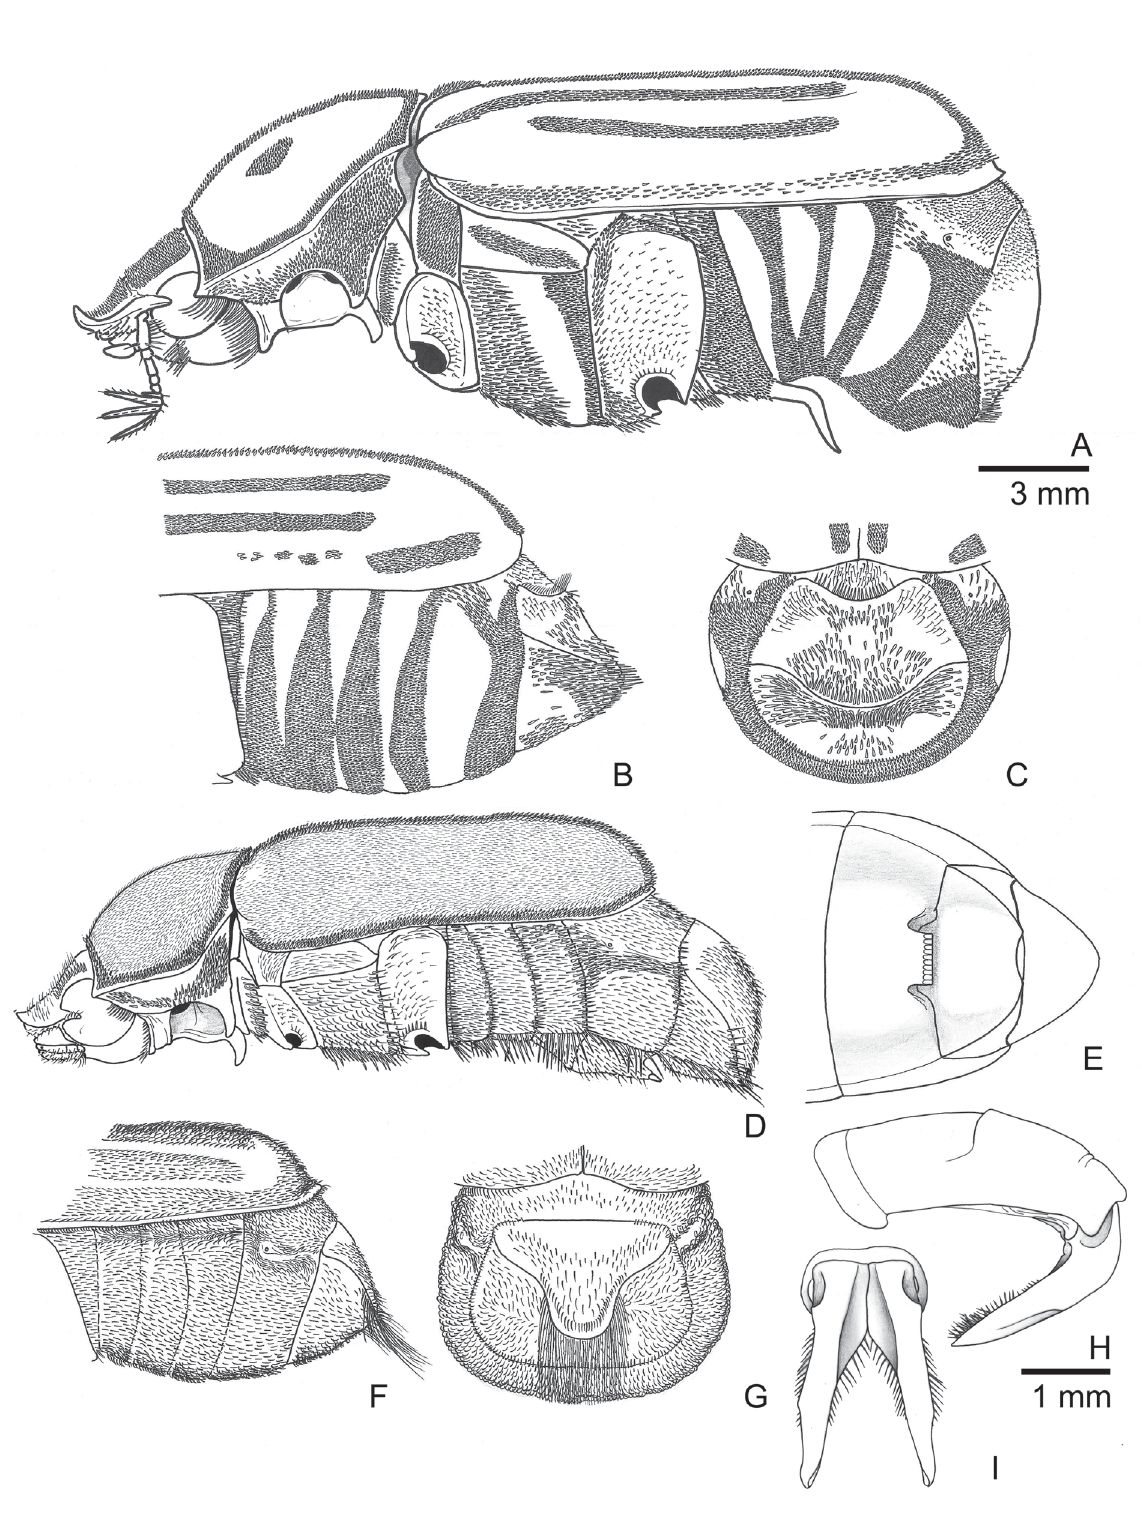
Fig. 14. A , D . Male habitus, lateral (without some appendages). B–C, F–G . Female abdomen detail (lateral, posterior). E . Male abdomen detail, ventral. H–I . Aedeagus (lateral, parameres